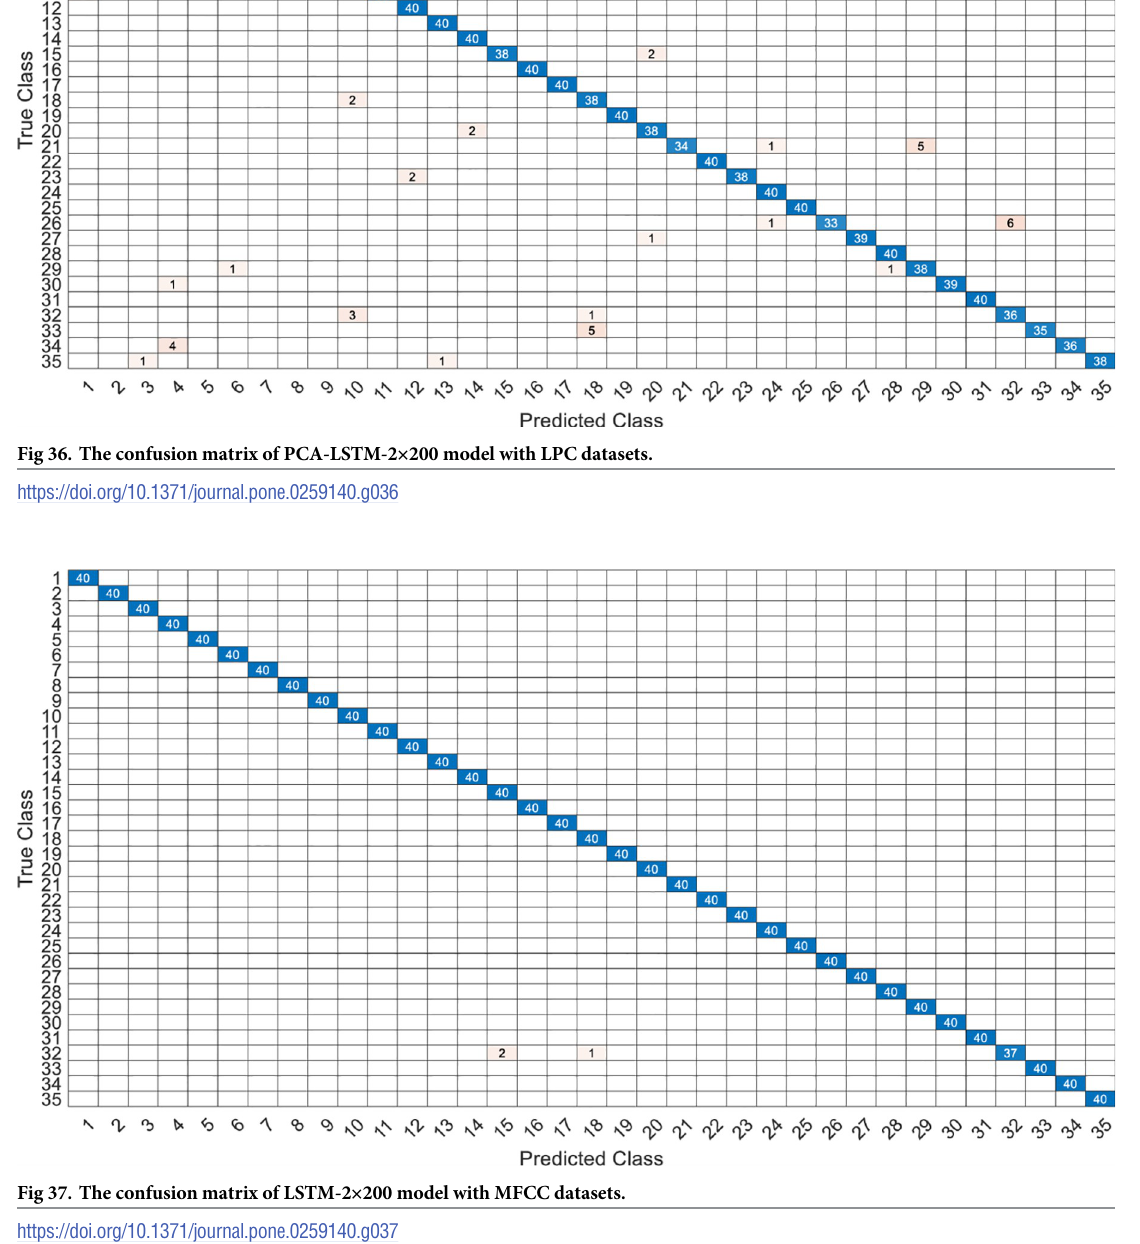
PLOS ONE | https://doi.org/10.1371/journal.pone.0259140 December23,